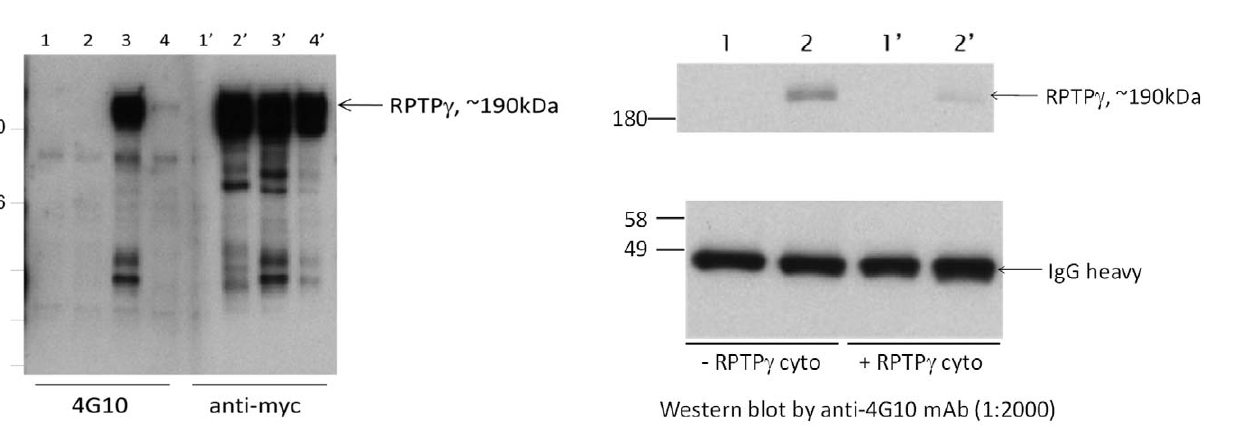
Figure 6. RPTP c dephosphorylated itself in vitro. Wild type RPTP c or RPTP c C1060S plasmids were transiently transfected into HEK293F and isolated from lysates with anti c-myc/protein G sepharoses. RPTP c wild type or C1060S on the protein G sepharose was denatured in 8 M urea to linearized protein as substrates for reaction following. The Purified RPTP c wild type, C1060s sepharose beads was then incubated with recombinant, active purified RPTP c cyto enzymes in assay buffer with urea at a final concentration of 0.375 M. Lanes 1 and 2 are RPTP c WT and RPTP c C1060S on protein G sepharose in a mock reaction without phosphatase in the same buffer, and lanes 1 9 and 2 9 are RPTP c wild type and RPTP c C1060S reacted with RPTP c cytoplasmic region as phosphatase. Samples were subjected to western blot analysis using anti-phosphotyrosine 4G10 mAb. The densitometry of each band was determined to estimate the extent of removal of phosphotyrosine on the protein. The reacted IgG heavy chain bands were used as internal control to ensure equal loading of samples. It is estimated by densitometry that 75% of phosphotyrosine from RPTPC1060S was removed by addition of RPTP c